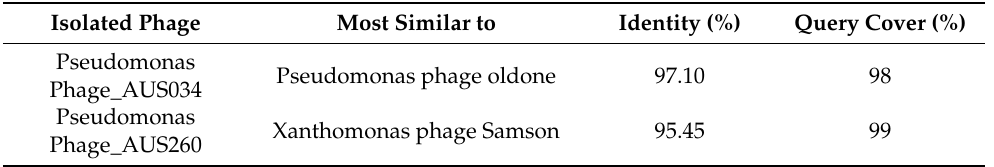
Figure 8. A phylogenetic tree constructed using whole genome sequences of the isolated phages together with the five most homologous sequences to each of these four, obtained from the GenBank database, using the Genome-BLAST Distance Phylogeny (GBDP) method and bootstrap support values from 100 replications. Table 9. Phages with sequences most similar to the isolated phages in the GenBank